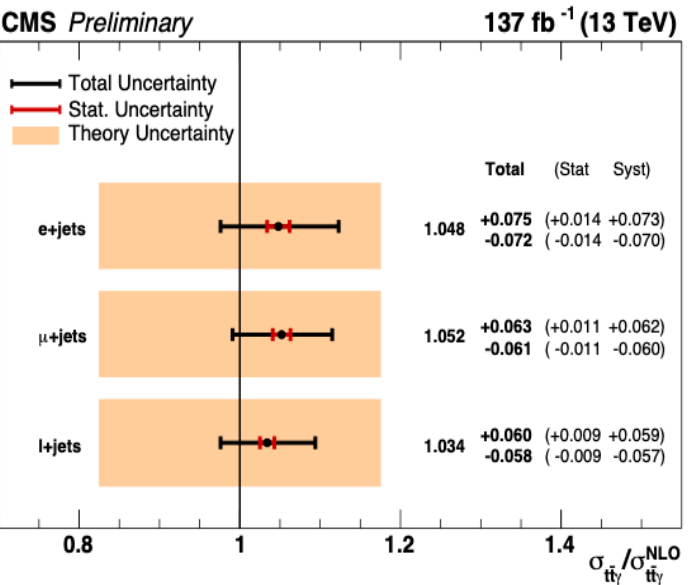
Figure 18. Inclusive t¯t γ production cross − section measurements by CMS in the single − lepton channel [47]. Results are also shown for the individual lepton flavour